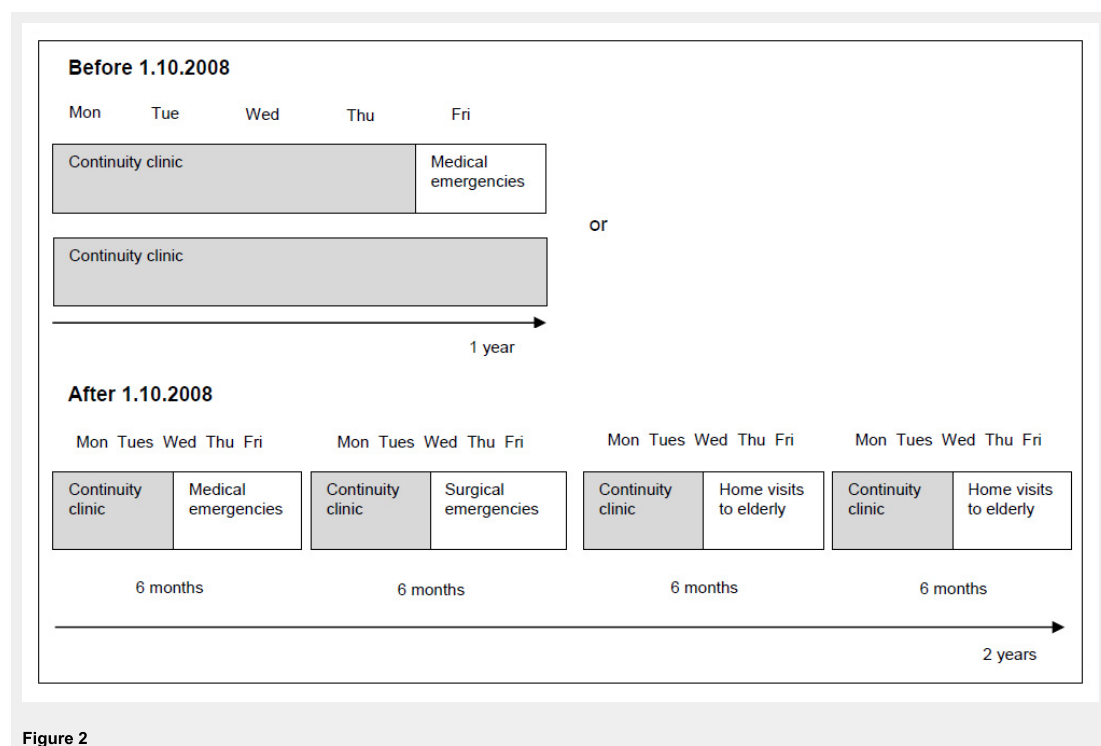
Figure 2 Model of a week organisation before and after the implementation of the new